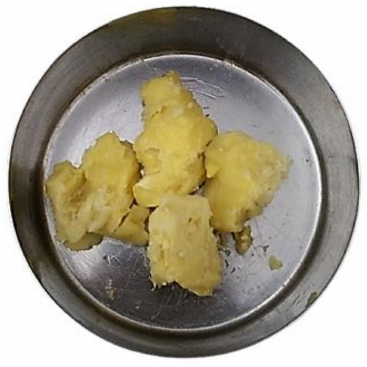
Figure 2. SC-CO 2 extracted